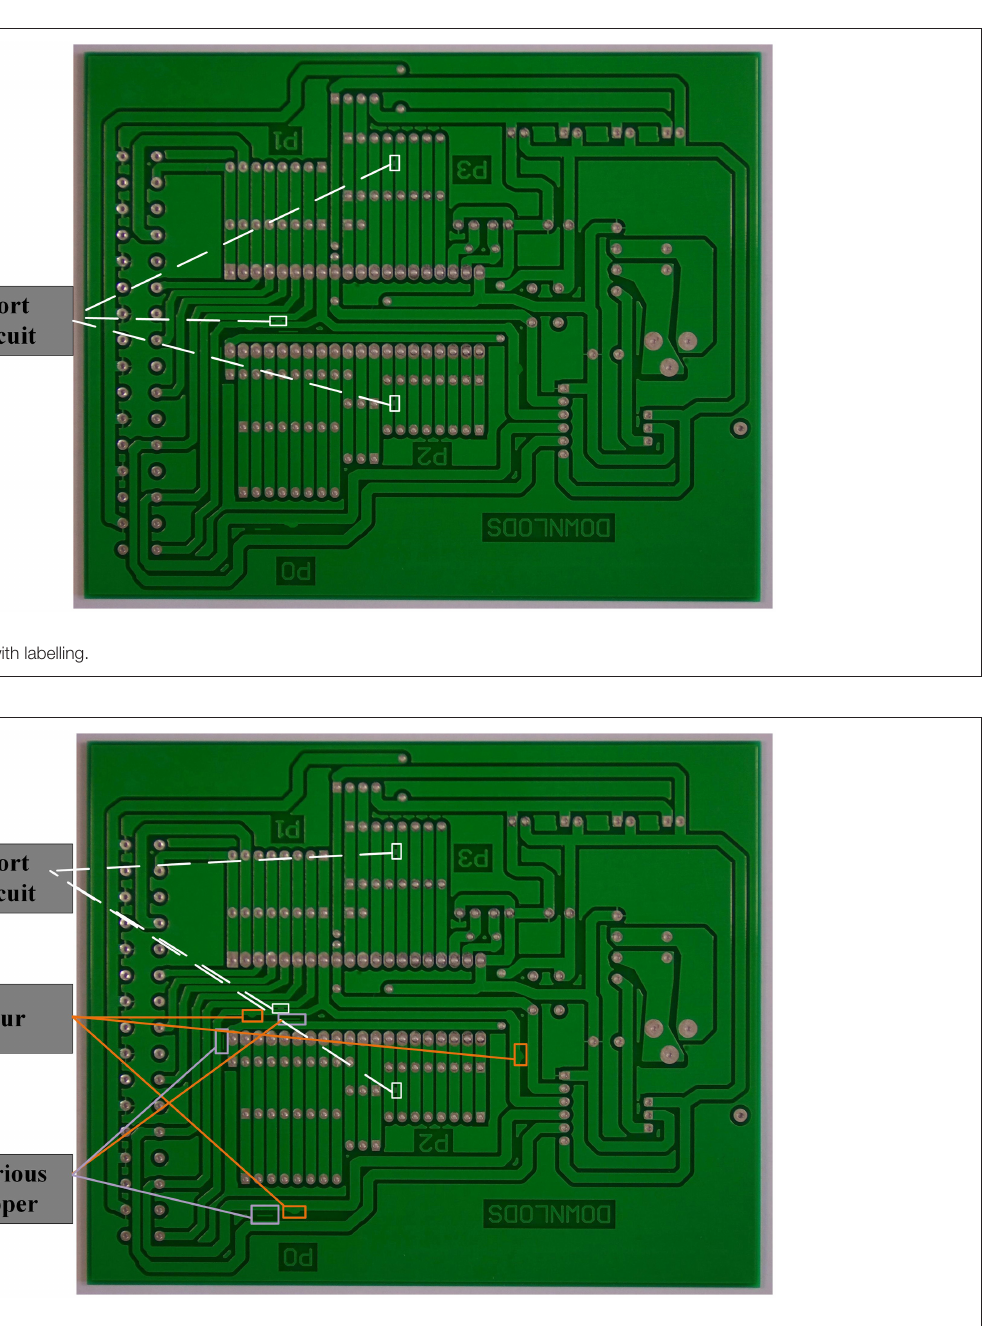
FIGURE 4 | The PCB image after data